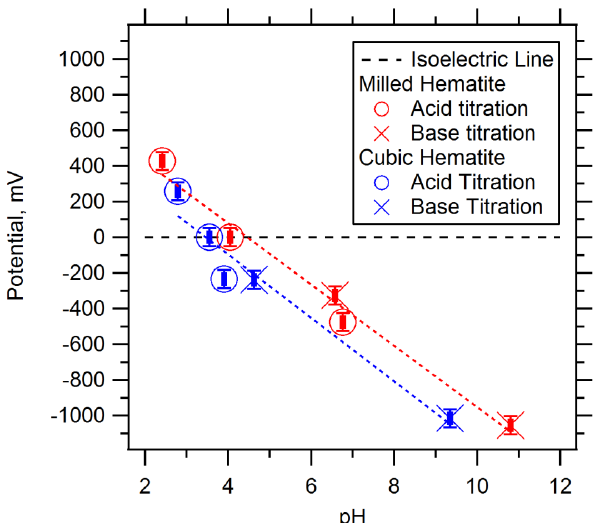
Fig. 2. Generation of charged particles by acid–base titration. Iso- electric line (black dashed) represents the pH, at which hematite particle surfaces show zero charge potential. The colored dashed lines represent fits for each hematite particle subset. Error bars rep- resent our experimental uncertainties ± 0.05 for the pH values and ± 50mV for the potential.